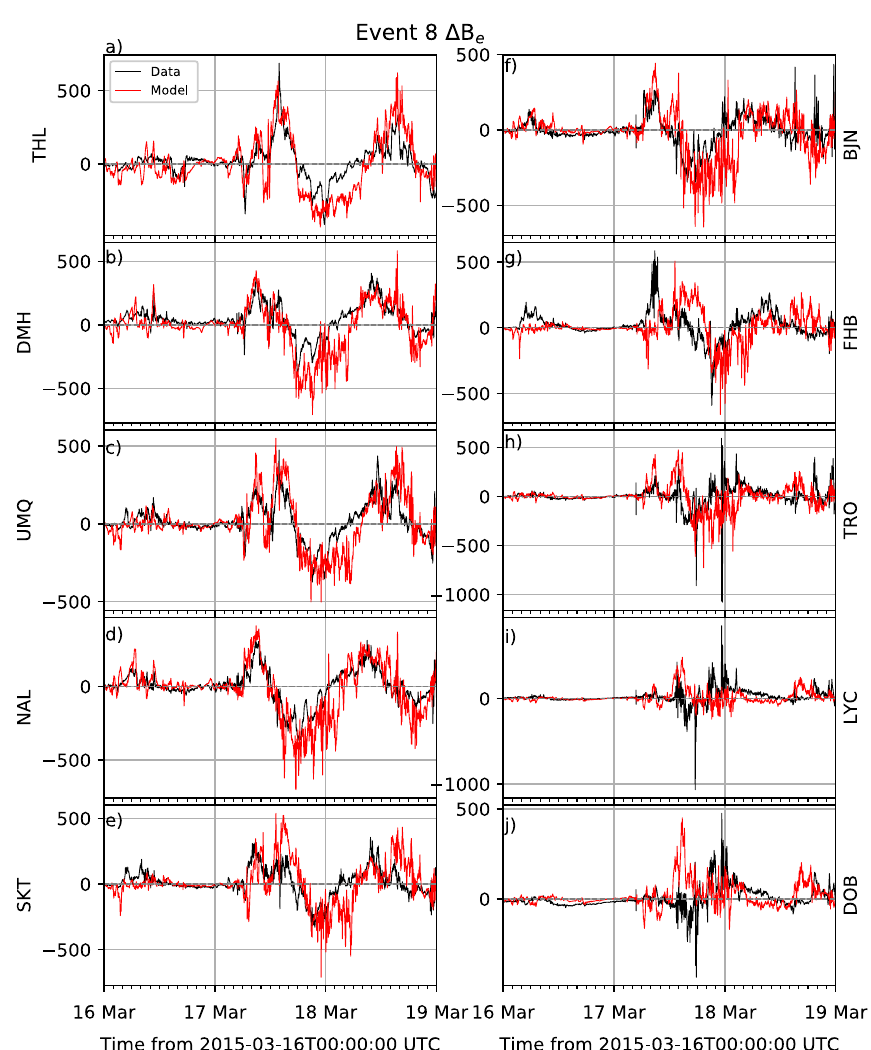
Fig. 4. Ground magnetic eastward perturbations, D B e at all ground magnetometer stations for event 8. The black line shows the observed perturbations and the red line shows the modelled ground